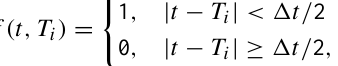
the position (x, y) . g(x, y, D i ) is a term at location (x, y) , a distance Di from the i th CG lightning flash given by: ( 1 , D i < 5 km g(x, y, D i ) = 0 , D i ≥ 5